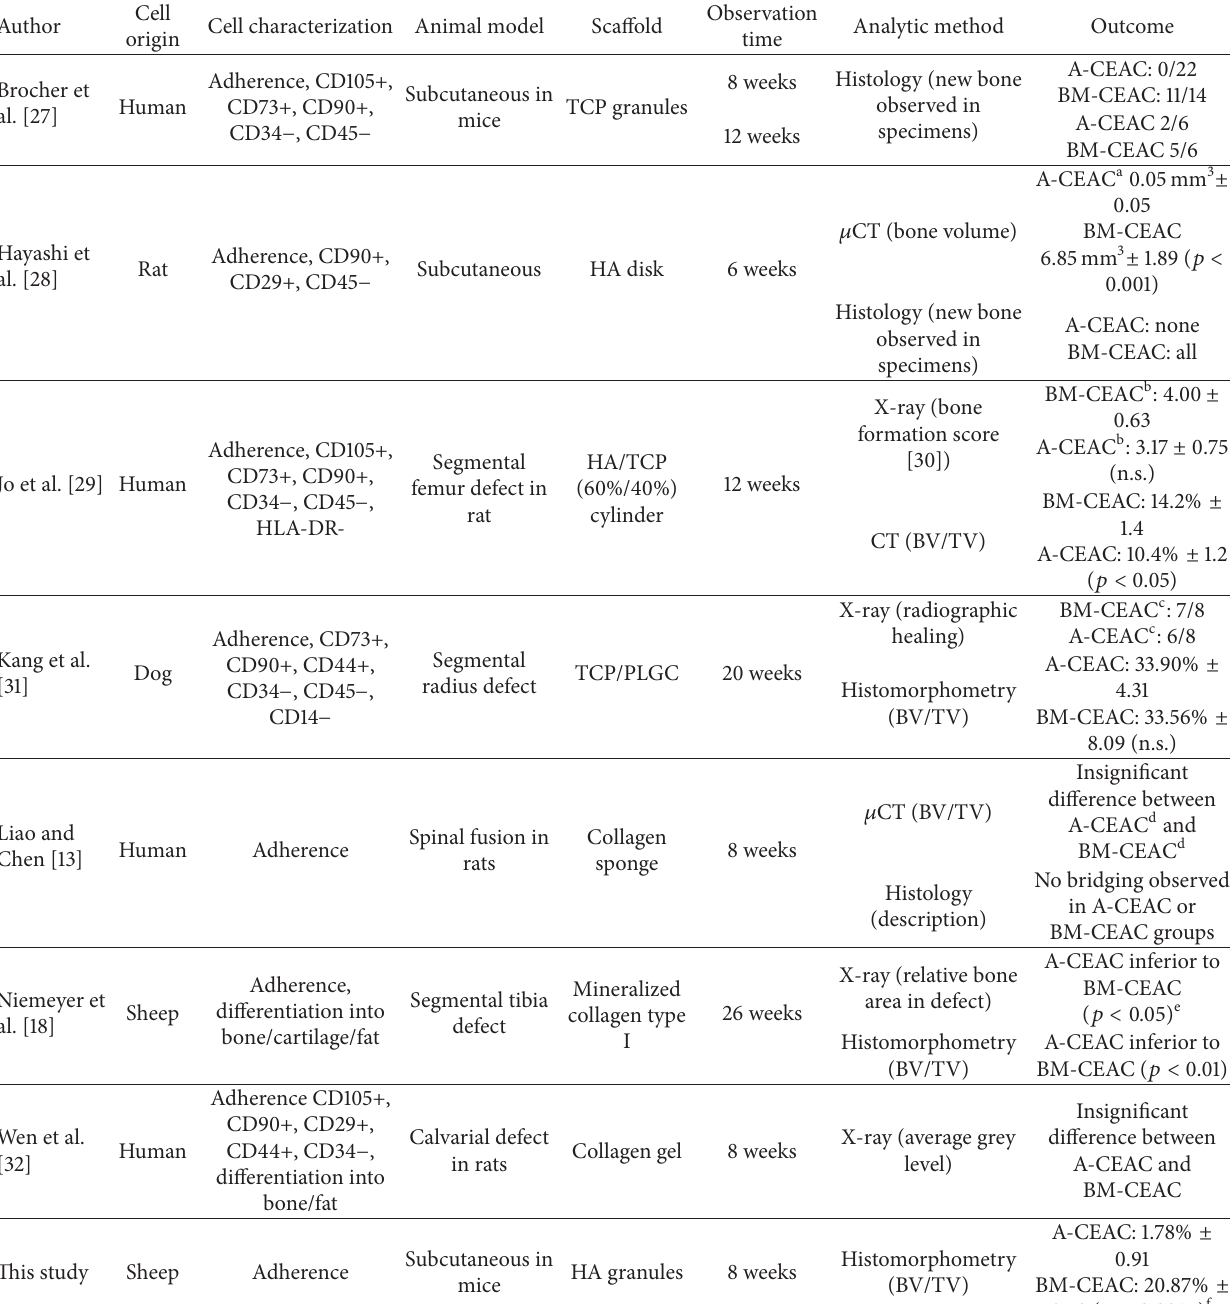
Table 2: Studies comparing A-CEAC and BM-CEAC without osteogenic gene transfection or differentiation prior to implantation. Only data related to bone formation is shown. All studies used CEAC from 2nd to 5th passages. 𝑝 values shown when available. Adapted with modifications from Liao and Chen